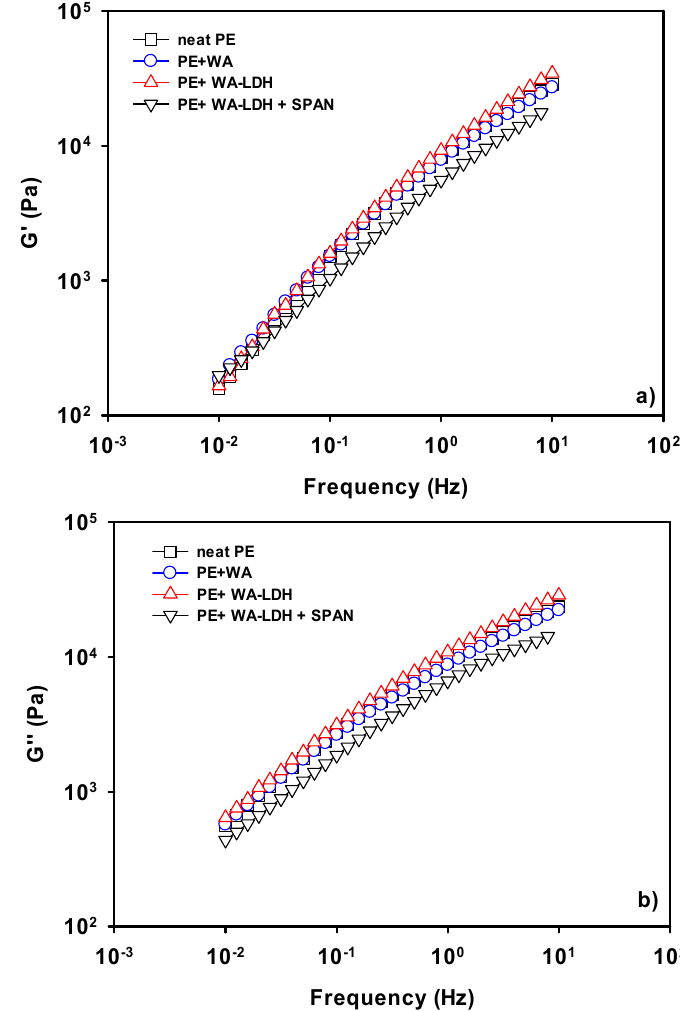
Figure 4. Storage ( a ) and loss ( b ) moduli of neat PE, PE + WA, PE + WA-LDH and PE + WA-LDH + surfactant at 190 °C.